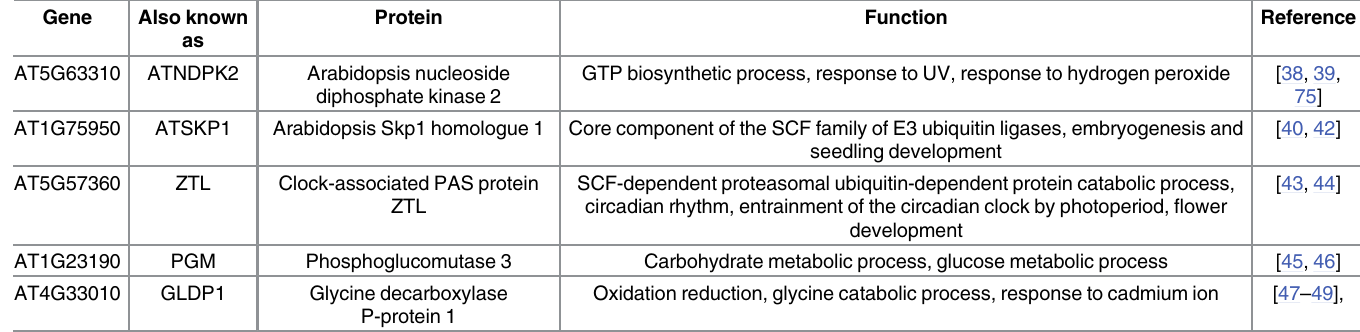
Table 1. Five validated genes identified by the shortest-path-based method. Gene Also known